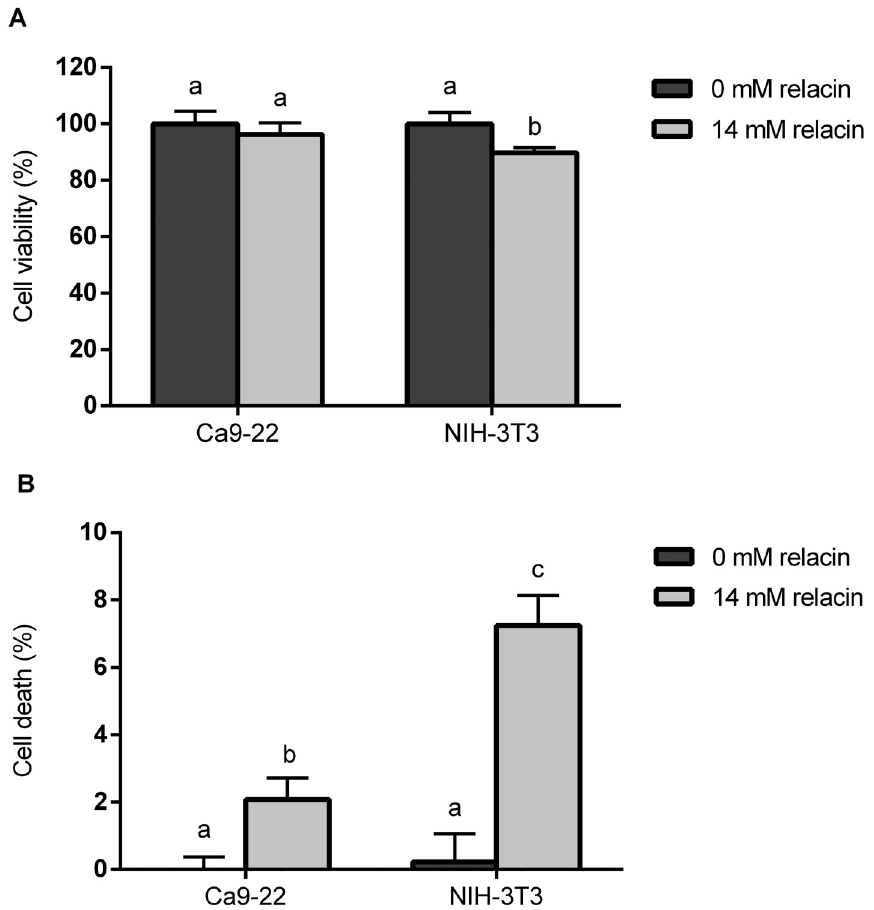
Figure 4- Effect of relacin treatment on Ca9-22 and NIH-3T3 cells. The confluent Ca9-22 or NIH-3T3 cells were treated with 14 mM relacin or culture medium (0 mM relacin) for 24 h. The cell viability was assessed by MTT assay (A) and the cell death was examined by measuring the LDH activity in extracellular culture medium (B). Different lowercase letters indicate significant difference in each cell line